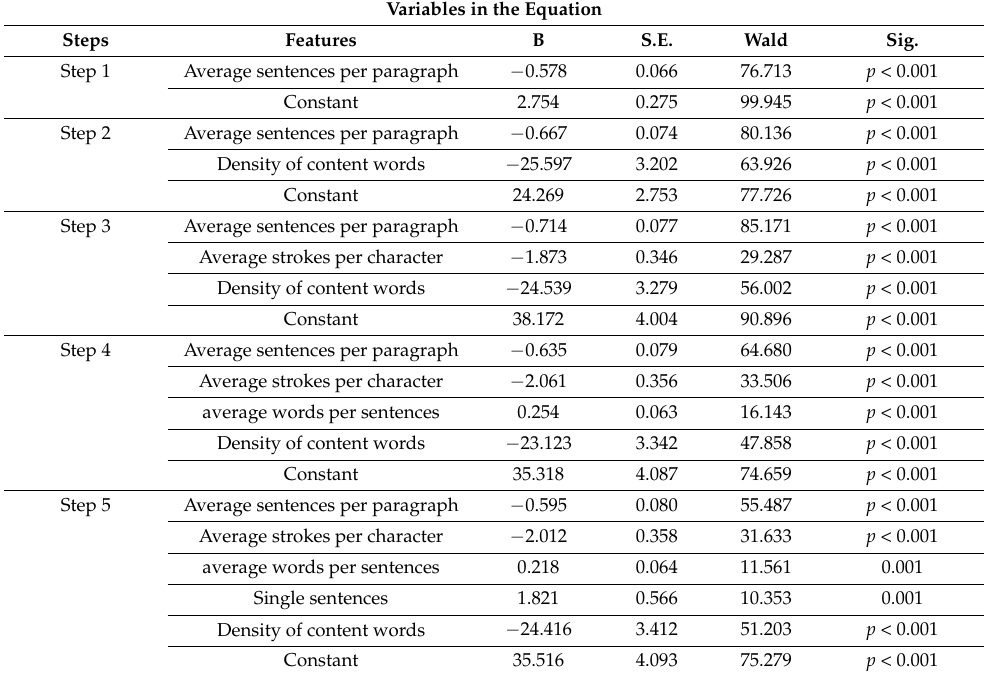
Table 3. Stepwise Regression (Variables in the